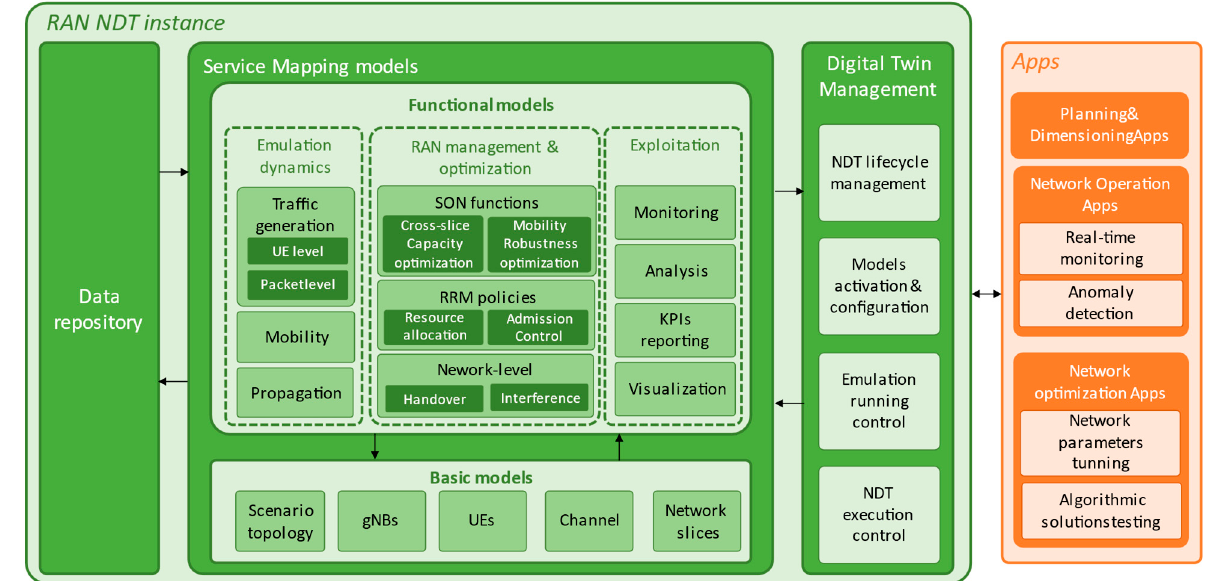
Figure 1. RAN NDT architecture and apps. The RAN NDT architecture includes the data repository, service mapping models to represent the RAN elements and operation, and digital twin management to manage the RAN NDT instance.